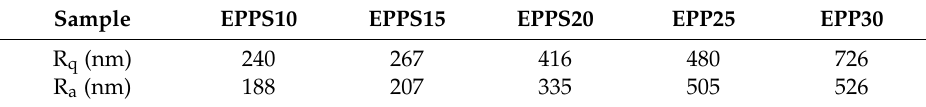
Table 1. The average roughness of the surfaces with di ff erent contents of silica